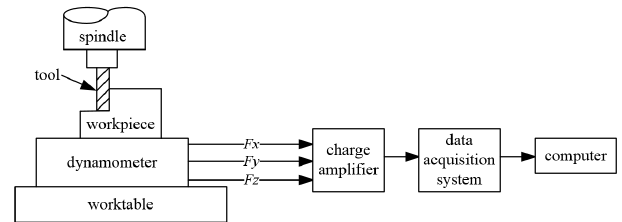
Figure 10. Schematic diagram of the milling force measuring sys-